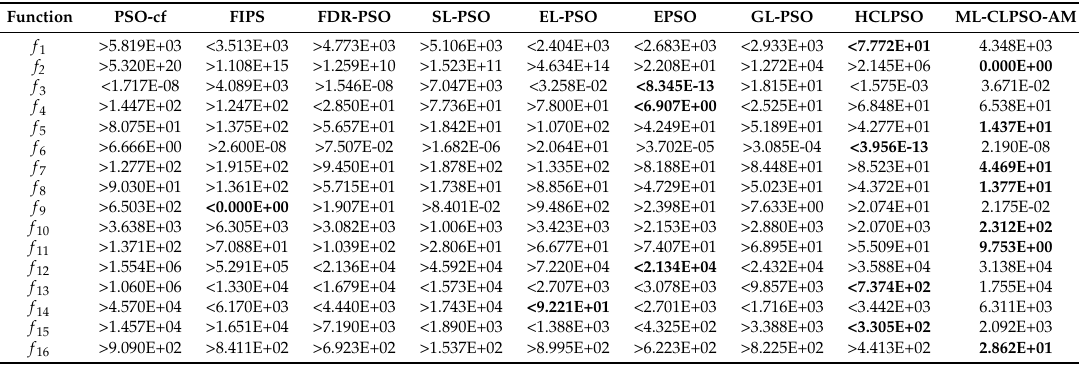
Table 3. Comparison test results with PSO